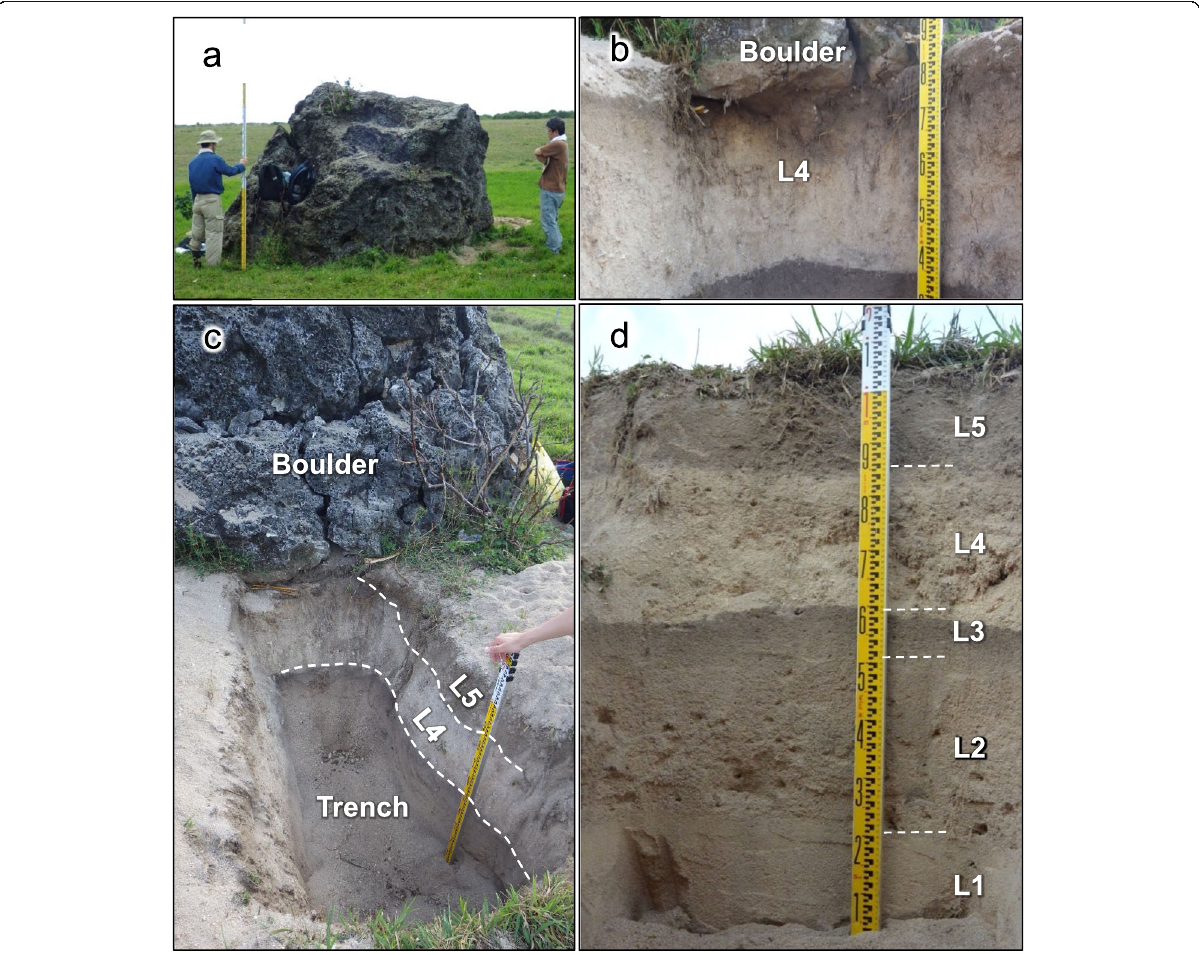
Fig. 4 Outcrop photographs: a tsunami boulder composed of Porites sp. at 7 m elevation; b trench below the boulder; c relation among the tsunami boulder, L4 and L5; d stratigraphy of the trench from L1 to L5. It is noteworthy that the boulder is deposited not on L5, but on